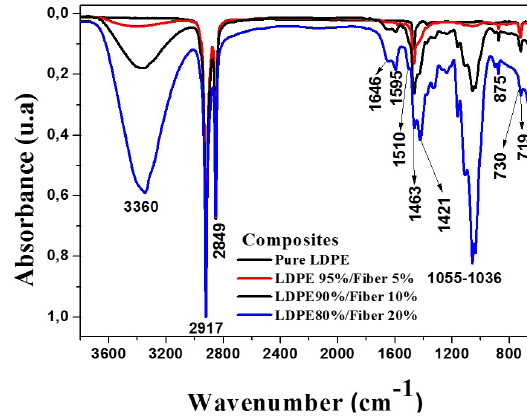
Figure 2. Absorption Spectrum of pure LDPE matrix and babassu fiber